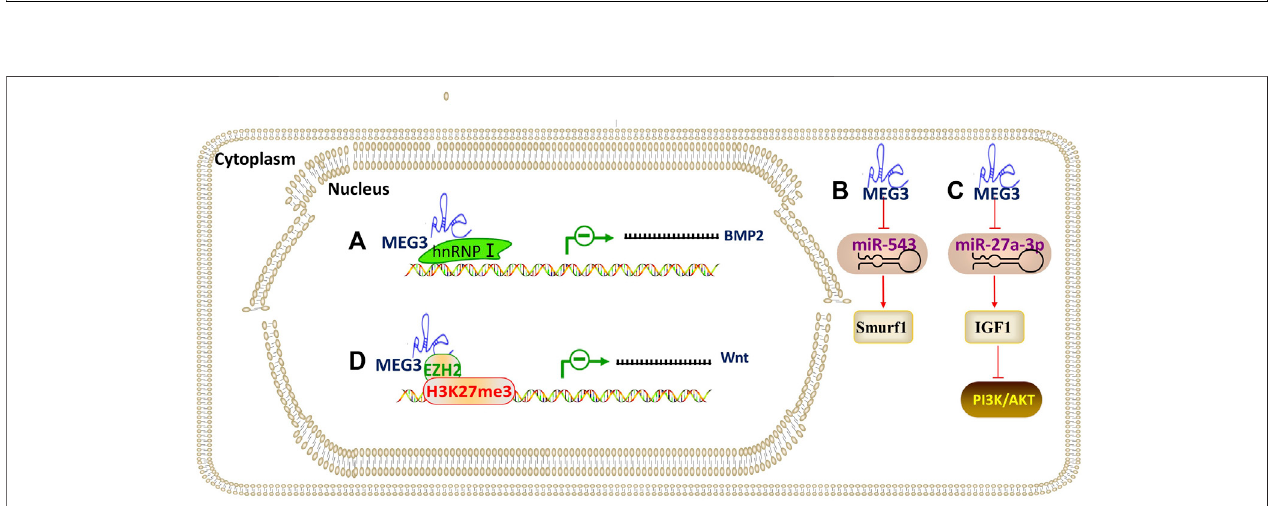
FIGURE 7 | The regulatory mechanism of lncRNA MEG3. Arrow indicates promotion and T indicates inhibition. (A) MEG3 leads to repression of BMP2 by competing with BMP2 mRNA for hnRNPs (an RNA-binding protein), which in turn inhibits osteogenic differentiation. (B) MEG3 promotes osteogenic differentiation through MEG3/miR-543/Smurf1 axis. (C) MEG3 promotes osteogenic differentiation through MEG3/miR-27a-3p/IGF1/PI3K/Akt axis. (D) MEG3 epigenetically regulating Wnt through the EZH2 regulation of H3K27me3 level on the Wnt genes